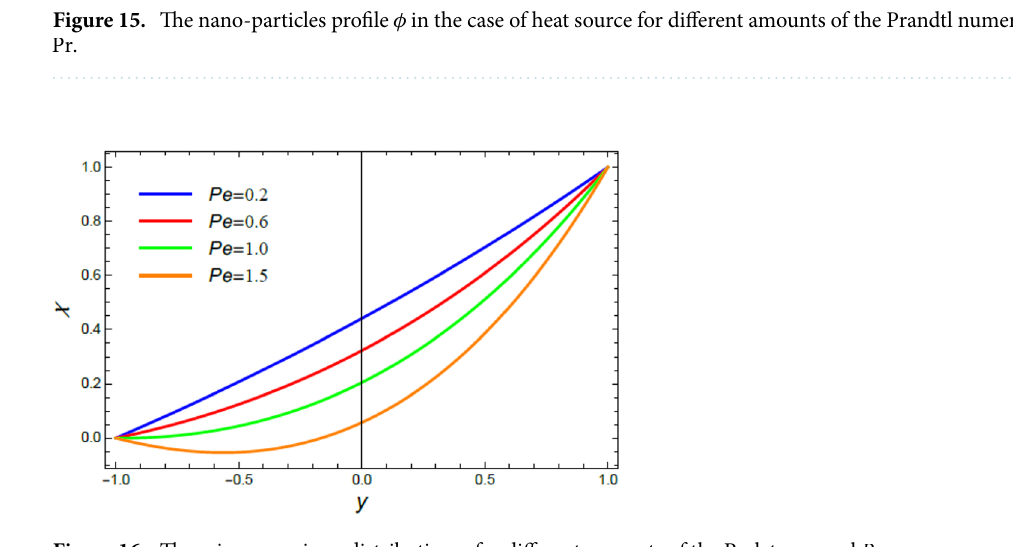
Figure 16. The microorganisms distribution χ for different amounts of the Peclet numeral Pe .